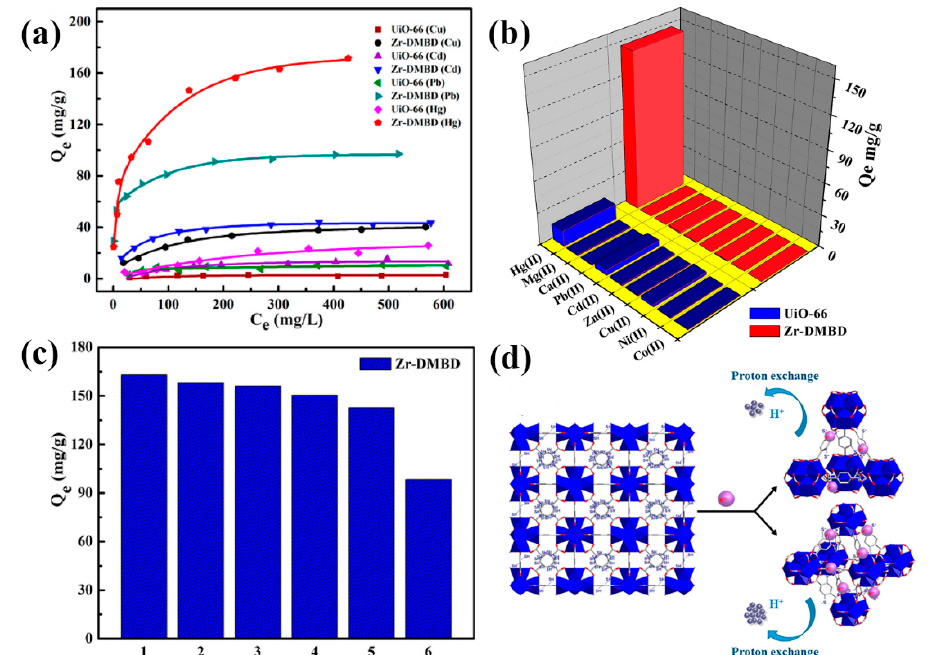
Figure 3. ( a ) Adsorption isotherms for the metal ion adsorption on UiO ‐ 66 and Zr ‐ DMBD (prepared using ZrCl 4 and 2,5 ‐ dimercapto ‐ 1,4 ‐ benzenedicarboxylic acid (H 2 DMBD)); ( b ) the selective adsorption of metal ions by UiO ‐ 66 and Zr ‐ DMBD in mixed solutions of nine coexisting metal ions with initial concentrations of 300 mg L − 1 each; ( c ) the reusability of Zr ‐ DMBD for Hg(II) adsorption; ( d ) Hg(II) coordination with S of thiol groups on Zr ‐ DMBD through a proton exchange reaction mechanism. Reproduced with permission from [67]. Copyright American Chemical Society, 2018.